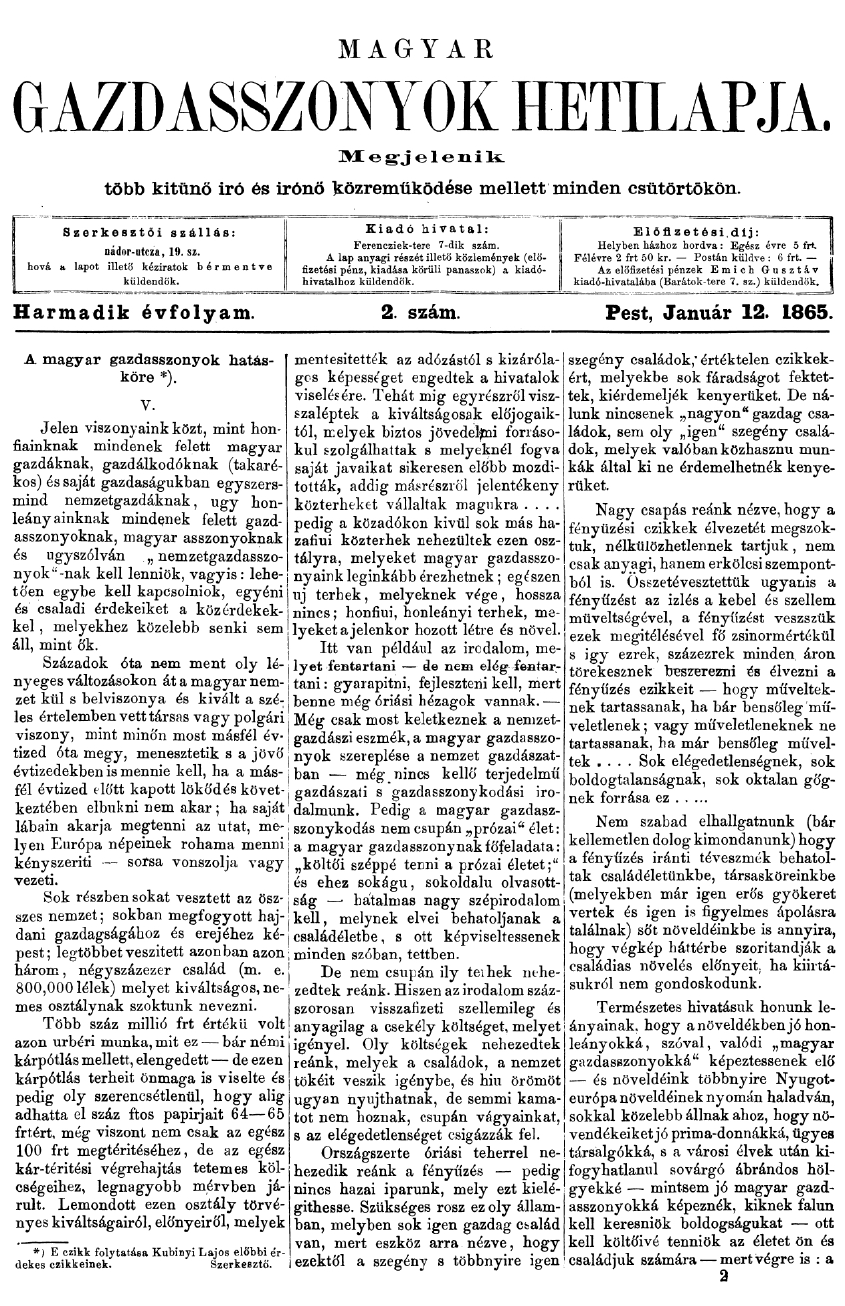
Front page of Magyar Gazdasszonyok Hetilapja [ Magazine of Hungarian Women’s Household Management ], 12 January 1865. National Széchényi Library, Newspaper and Periodical